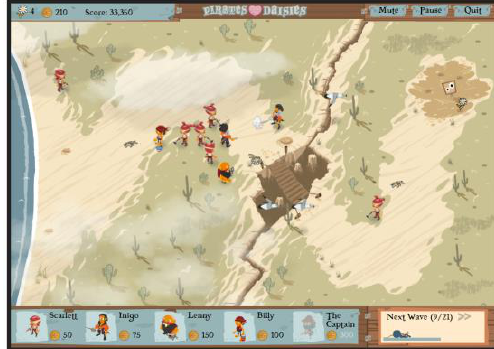
Fig. 2. Example of tactical location of battle units in HTML5 game “Pirates Love Daisies”.